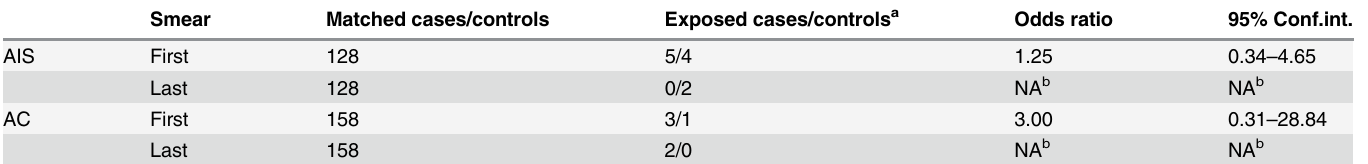
Table 2. Risk of cervical adenocarcinoma given by C . trachomatis infection in the first and last smear, calculated as odds ratio via conditional logistic regression where possible. Smear Matched cases/controls Exposed cases/controls a Odds ratio 95%